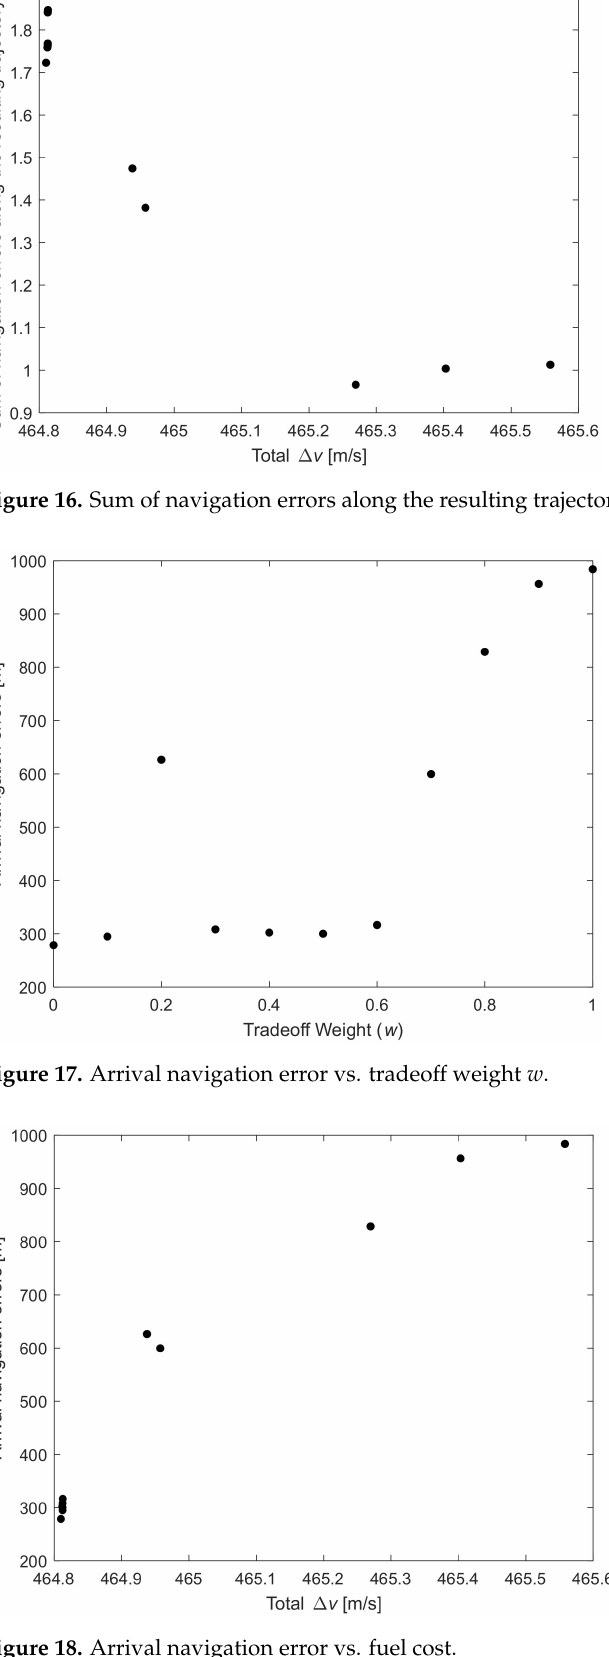
Figure 18. Arrival navigation error vs. fuel